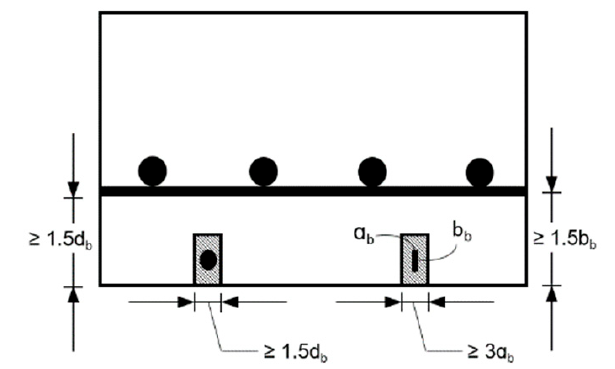
Figure 6. Groove size for installation of NSM FRP.